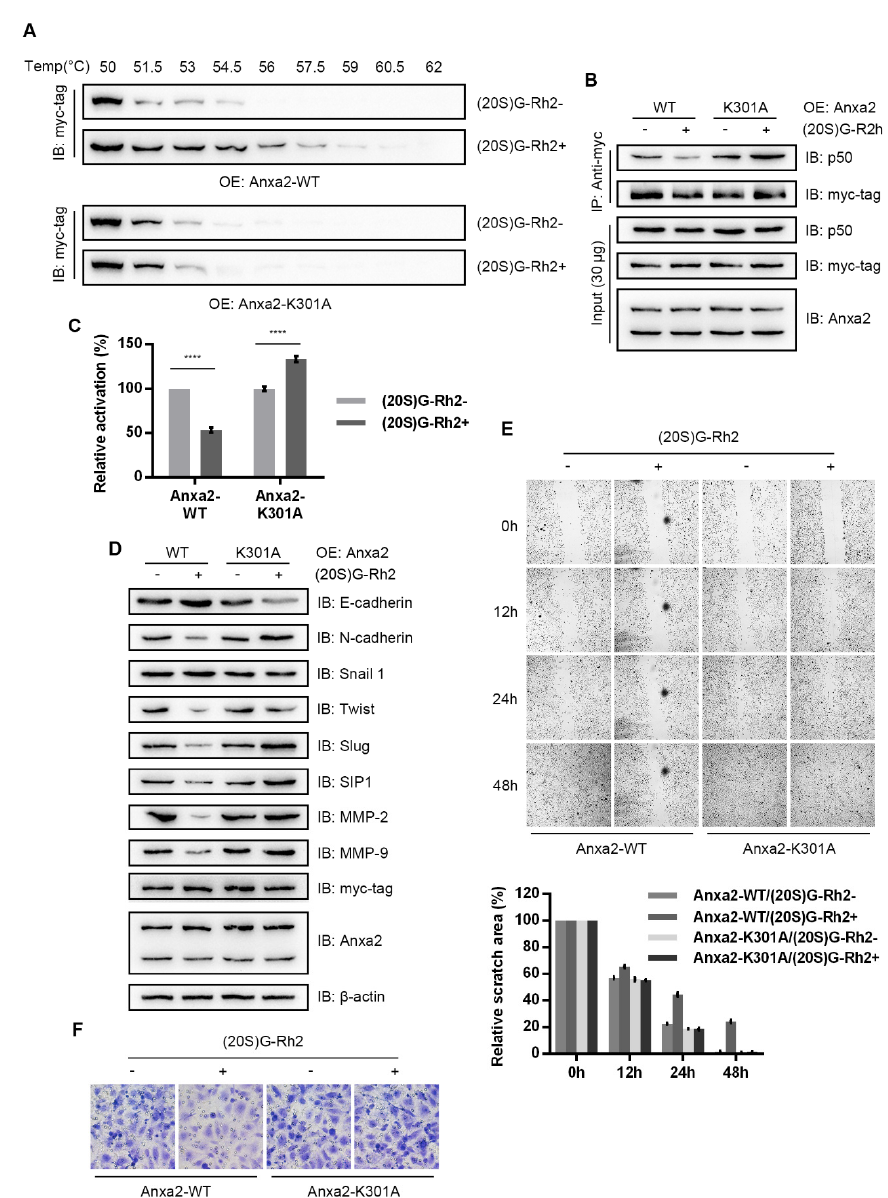
Figure 5. Anxa2-K301A protects MDA-MB-231 cells from (20S)G-Rh2-induced NF- κ B inhibition. ( A ) A cellular thermal shift was performed in MDA-MB-231 cells transfected with Anxa2-WT and Anxa2-K301A under 10- μ M-(20S)G-Rh2 treatment or not. ( B ) An immuno-precipitation was performed with anti-myc-tag antibody in protein extract from MDA-MB-231 cells transfected with Anxa2-WT and Anxa2-K301A under 6- μ M-(20S)G-Rh2 treatment or not. A total of 30 μ g of whole-cell protein extract was loaded as input. ( C ) NF- κ B activity was determined via a dual luciferase reporter assay in MDA-MB-231 cells transfected with Anxa2-WT and Anxa2-K301A under 6- μ M-(20S)G-Rh2 treatment for 12 h or not. ( D ) The protein levels of indicated genes were determined by immuno-blot in MDA-MB-231 cells transfected with Anxa2-WT and Anxa2-K301A under 6- µ M-(20S)G-Rh2 treatment or not. A total of 30 µ g of whole-cell protein extract was loaded for immuno-blotting assay. ( E ) A wound healing assay was performed with MDA-MB-231 cells transfected with Anxa2-WT and Anxa2-K301A under 6- µ M-(20S)G-Rh2 treatment or not. Relative scratch area was shown below the microscopy images. ( F ) A Transwell invasion assay was performed with MDA-MB-231 cells transfected with Anxa2-WT and Anxa2-K301A under 6- µ M-(20S)G-Rh2 treatment or not. All experiments were repeated for three times and all data are shown as mean ± SD, with **** presenting p < 0.0001, *** presenting p < 0.001, ** p < 0.01, * presenting p < 0.05 and ns presenting p >